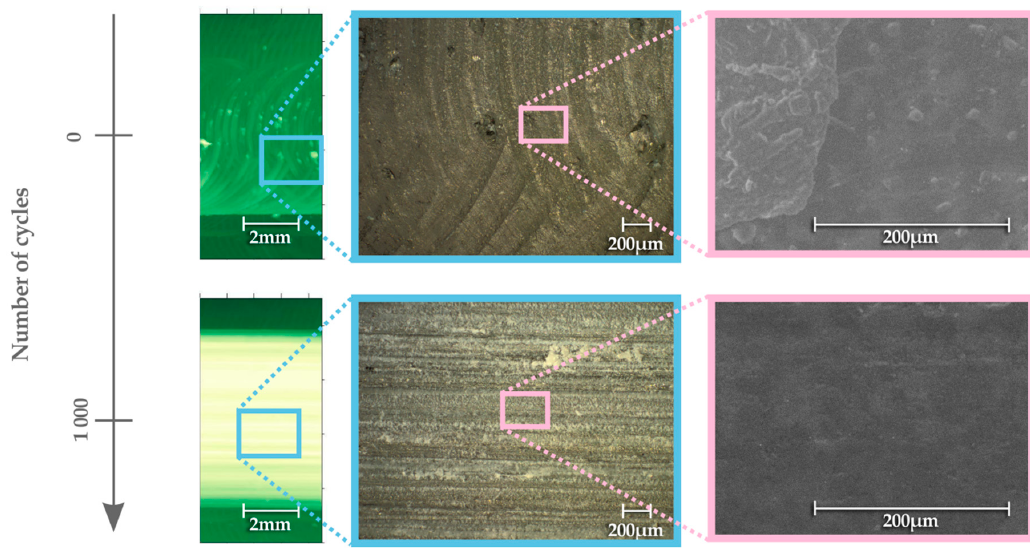
Figure 12. Profilometer topography, optical microscope images and SEM images of MWCNTs 0.25 wt.% sample after 0 and 1000 cycles of abrasive wear.